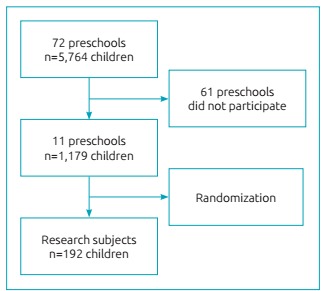
Flowchart for definition of research subjects.